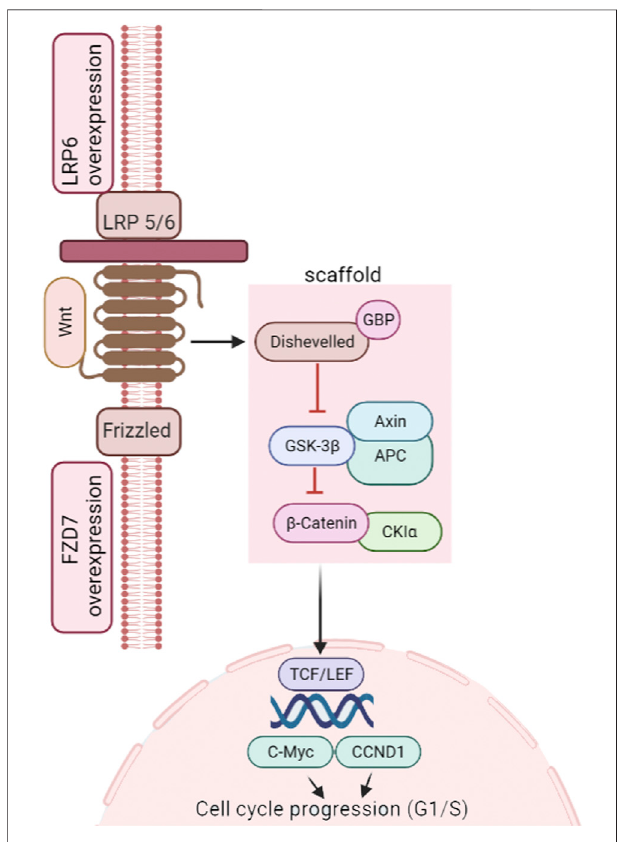
FIGURE1 | Wnt/ β -catenin pathway in TNBC instigation. Figure adapted from the KEGG pathway